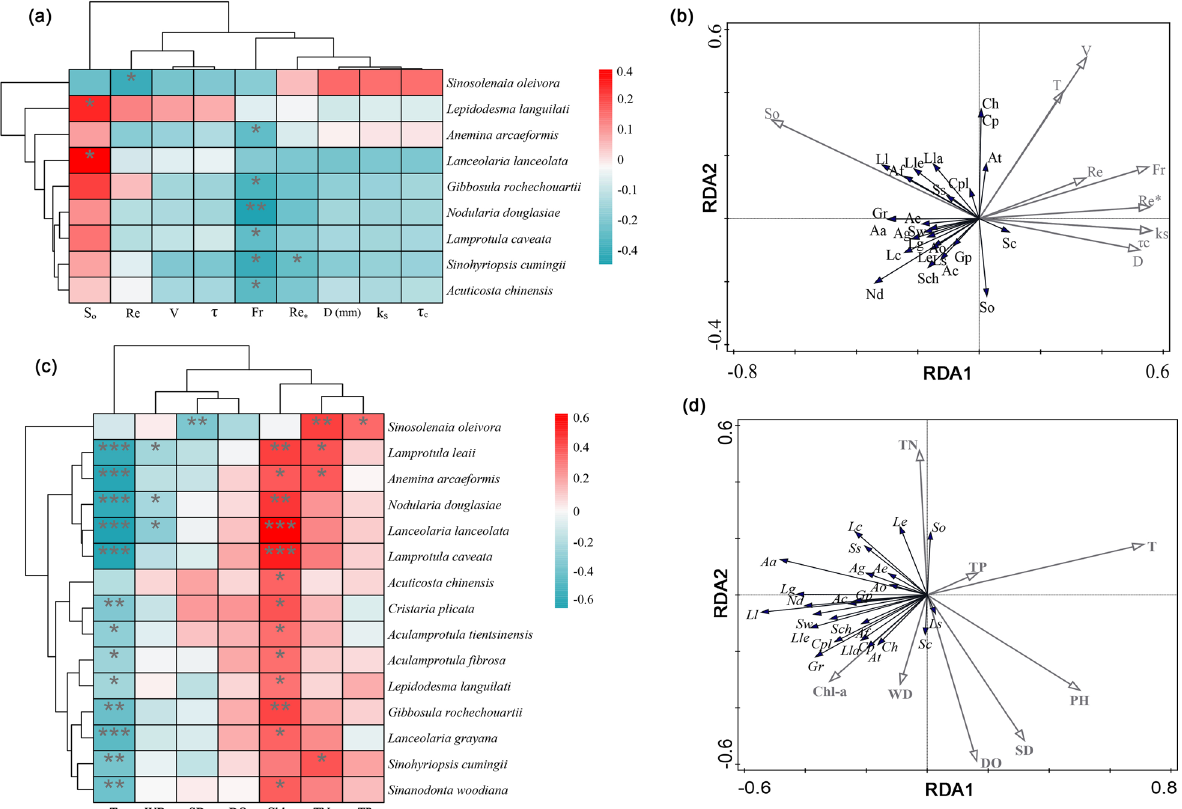
Fig. 5 Correlation between density of freshwater mussel species and hydraulic ( a , b ) and physicochemical variables ( c , d ) based on heat map analysis and redundancy analysis (RDA). The clustering dendrograms of heat maps including the distance metrics of density of freshwater mussel species, hydraulic and physicochemical variables used to produce it. Horizontal coordinates are hydraulic and physicochemical variables in heat map analysis, vertical coordinates are density of freshwater mussel species. Red shows positive correlation between density of freshwater mussel species and hydraulic and physicochemical variables. Blue shows negative correlation between density of freshwater mussel species and hydraulic and physicochemical variables. The color patch gradient is used to show the value of R 2 . The clustering dendrograms on the left and top are the result of clustering of species density (left), hydraulic and physicochemical variables (top), respectively. Significant results are in * (* p < 0.05; ** p < 0.01; *** p < 0.001). Dissolved oxygen (DO; mg/L), hydrogen ions (pH), salinity (Sal; mg/L), turbidity (TURB; NTU), and water temperature ( T ; °C), chlorophyll-a (Chl-a; mg/L), water velocity ( V ; m/s), water depth (WD; m), Total nitrogen (TN; mg/L) and total phosphorus (TP; mg/L), D (mm), Sorting index (S o , unitless), Bed roughness ( k s , mm), Froude number (Fr, unitless), Reynolds number (Re, unitless), Boundary Reynolds number (Re*, unitless), Shear velocity ( V , m/s), Shear stress ( τ , N/m 2 ), Critical shear stress ( τ c , N/m 2 ). Code of freshwater mussel species see Additional file 2: Table